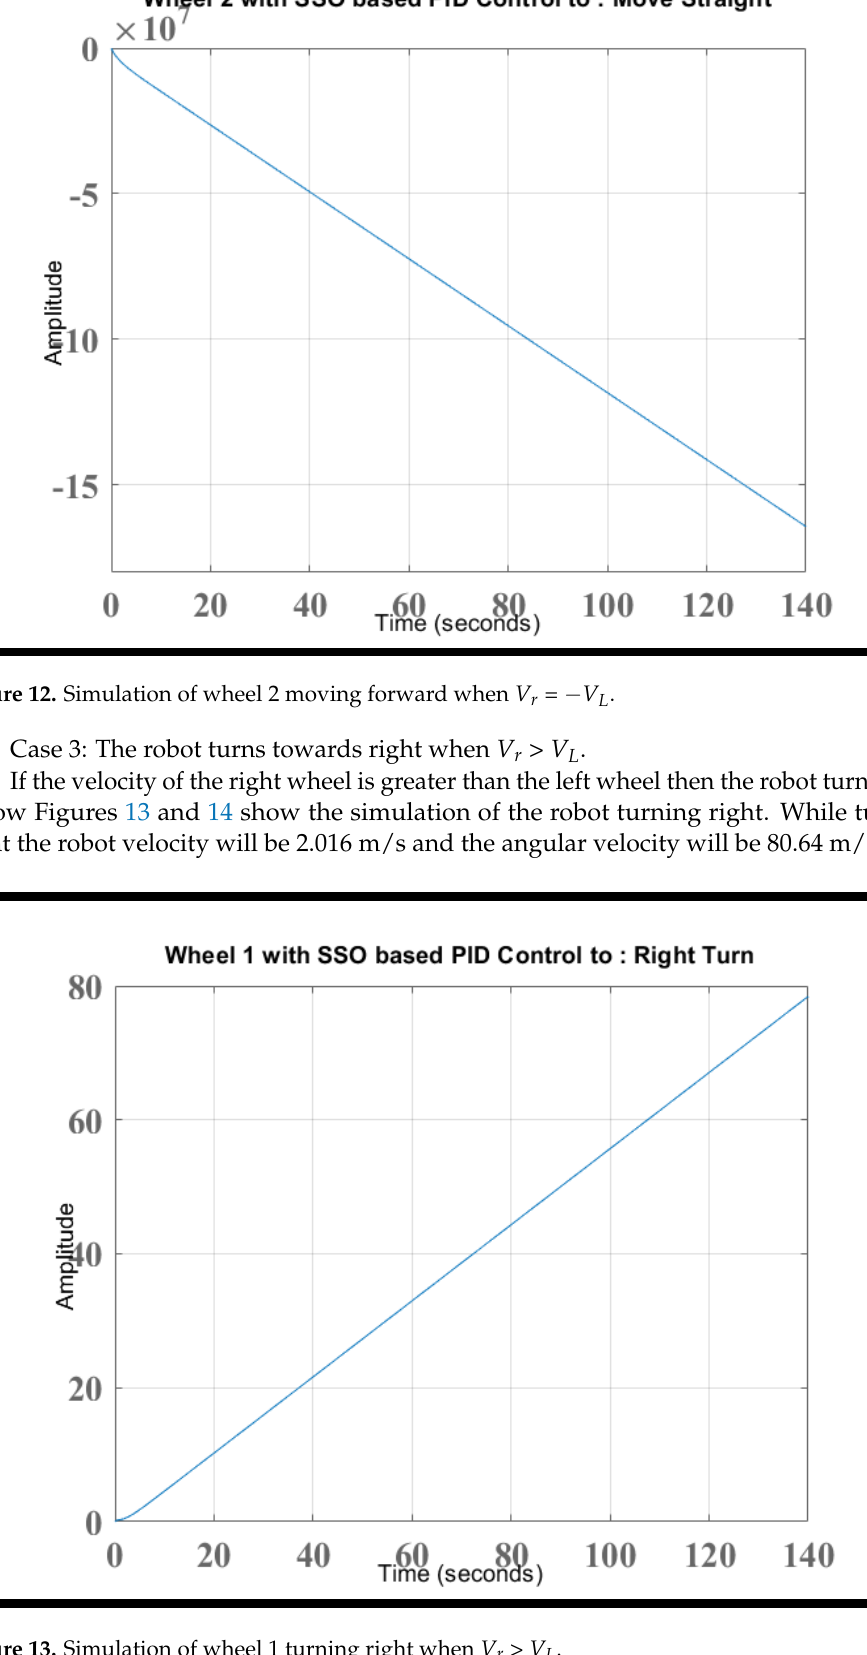
Figure 13. Simulation of wheel 1 turning right when V r > V L .